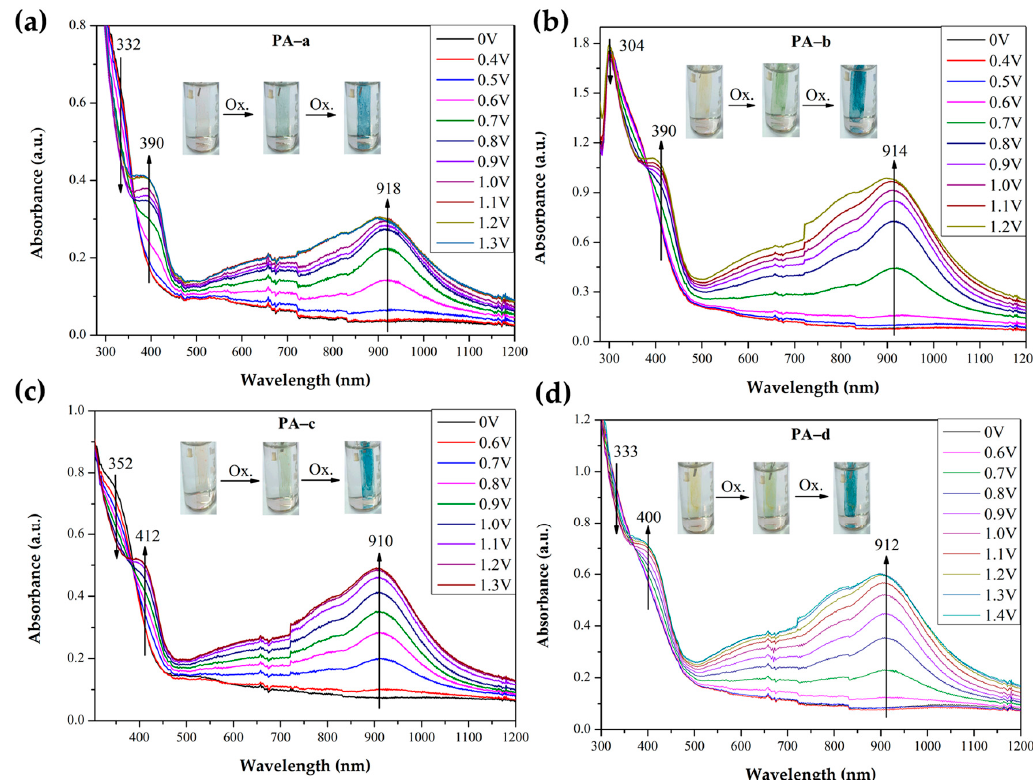
Figure 5. The electronic absorption spectrum of film of PA–a ( a ); PA–b ( b ); PA–c ( c ) and PA–d ( d ) was carried out in 0.1 M Bu 4 NClO 4 /ACN as the supporting electrolyte.